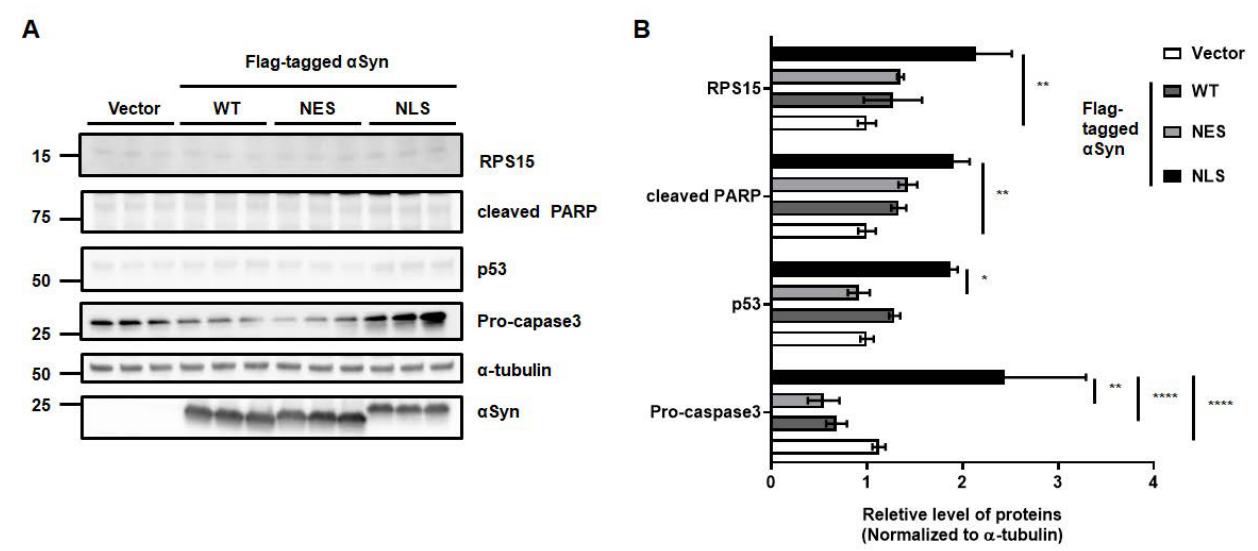
Figure 2. Nuclear localization of α Syn is responsible for apoptosis and ribosomal biogenesis in MEF. ( A , B ) The markers of apoptosis, such as pro-caspase3, p53, and cleaved Poly (ADP-ribose) polymerase (PARP), and ribosomal biogenesis marker, viz. 40S ribosome protein 15 (RPS15), were induced by the ectopic expression of nuclear α Syn. The densities of protein bands assessed using Western blotting were estimated and compared by the normalization with the density of β -tubulin band. We used one-way ANOVA with Bonferroni’s post hoc test. Data are represented as the mean ± SEM. N = 3;